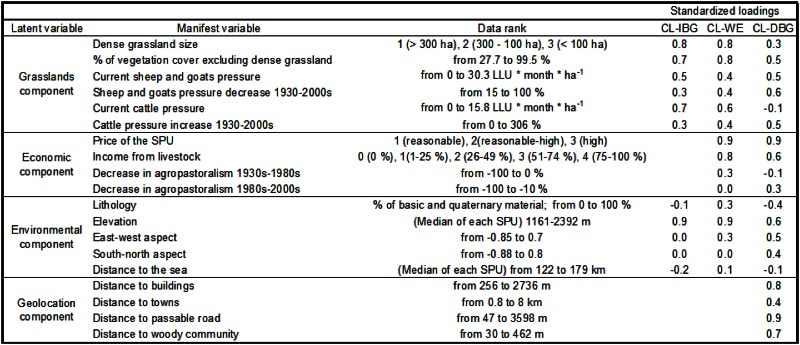
Standardized loadings (correlations) between each manifest variable and the corresponding exogenous latent variable.The correlations are for the connectivity losses caused by increases in biomass and greenness (CL-IBG), woody encroachment (CL-WE), and decreases in biomass and greenness (CL-DBG).